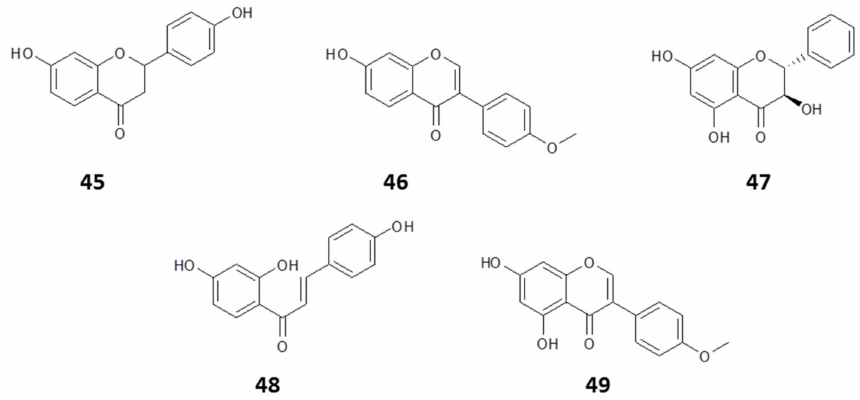
Figure 8. Structures of some flavonoids with antileishmanial activity isolated from Brazilian propolis and loaded into polymeric nanoparticles